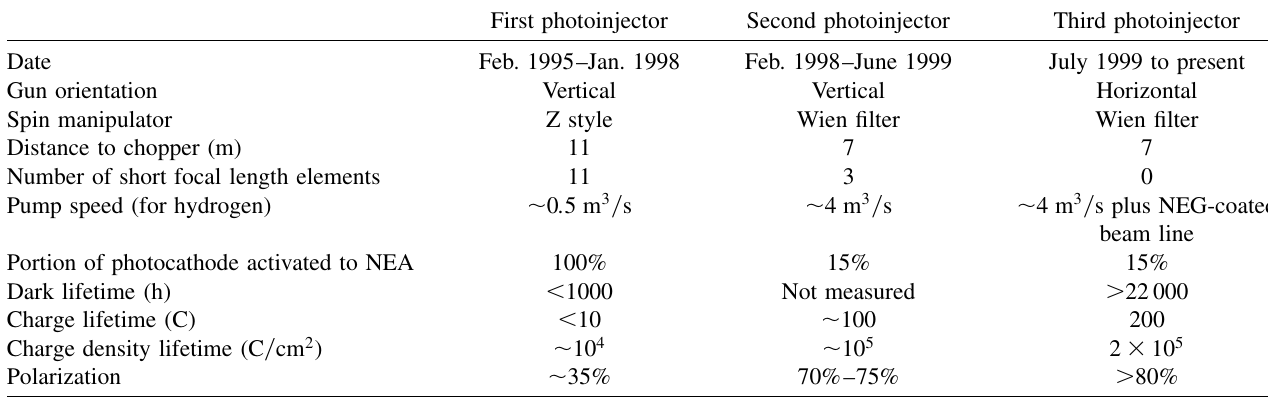
TABLE I. Key features of each CEBAF photoinjector, with explanation for each value described within the text. Lifetime values for the first and second photoinjectors were not determined with great accuracy and represent